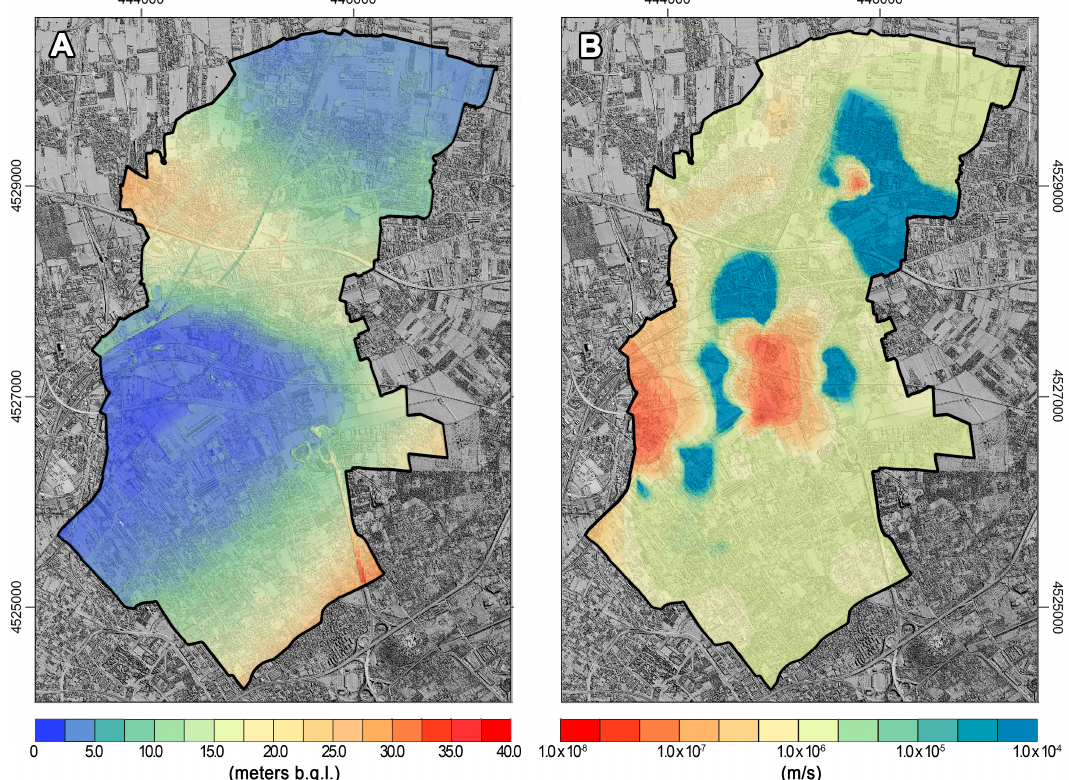
Figure 9. ( A ) Water table depth map; ( B ) equivalent saturated hydraulic conductivity (K sat.eq. ) of the